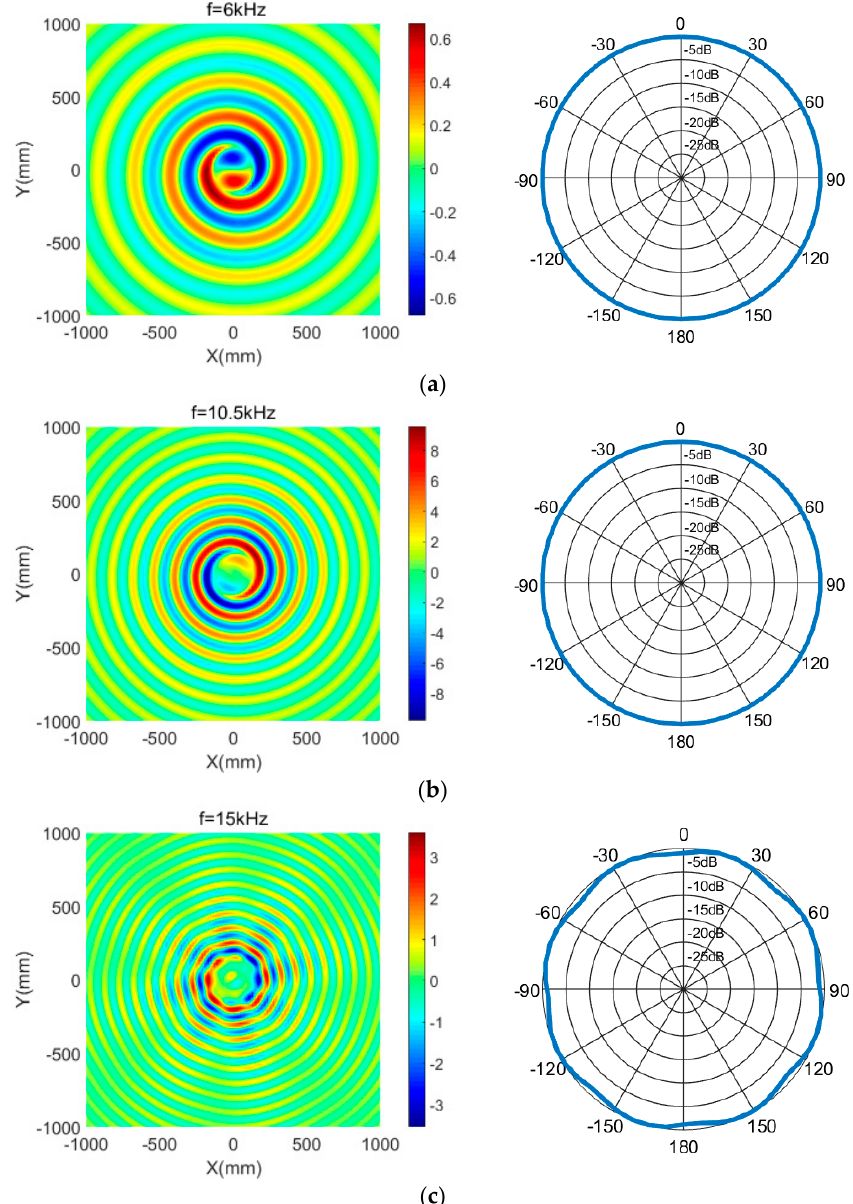
Figure 9. ( a ) The sound pressure distribution and sound pressure level directivity of the transducer at 6 kHz; ( b ) the sound pressure distribution and sound pressure level directivity of the transducer at 10.5 kHz; ( c ) the sound pressure distribution and sound pressure level directivity of the transducer at 15 kHz.